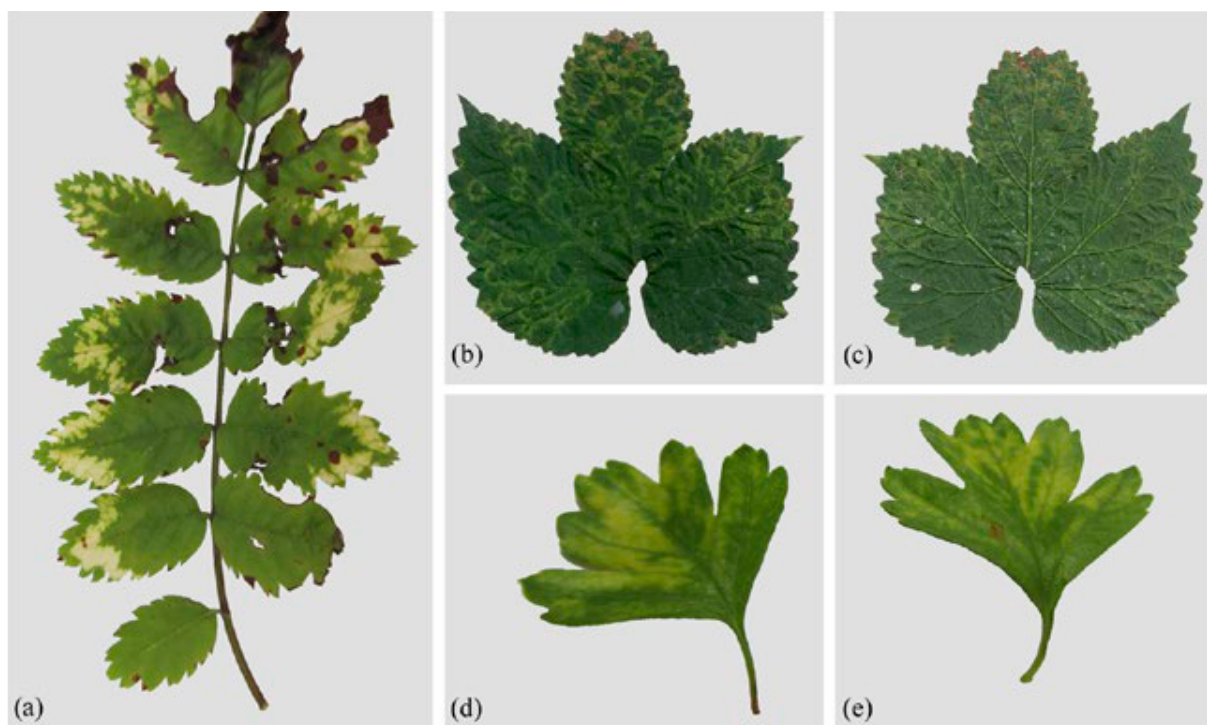
Figure 2. Symptoms associated with infection by ApMV in the form of line patterns on leaves of European mountain ash (a), hop (b) and (c) and hawthorn (d) and (e). Photos (b) and (c) provided by Dr Petr Svoboda from Hop Research Institute Co., Ltd. (Zatec, Czech